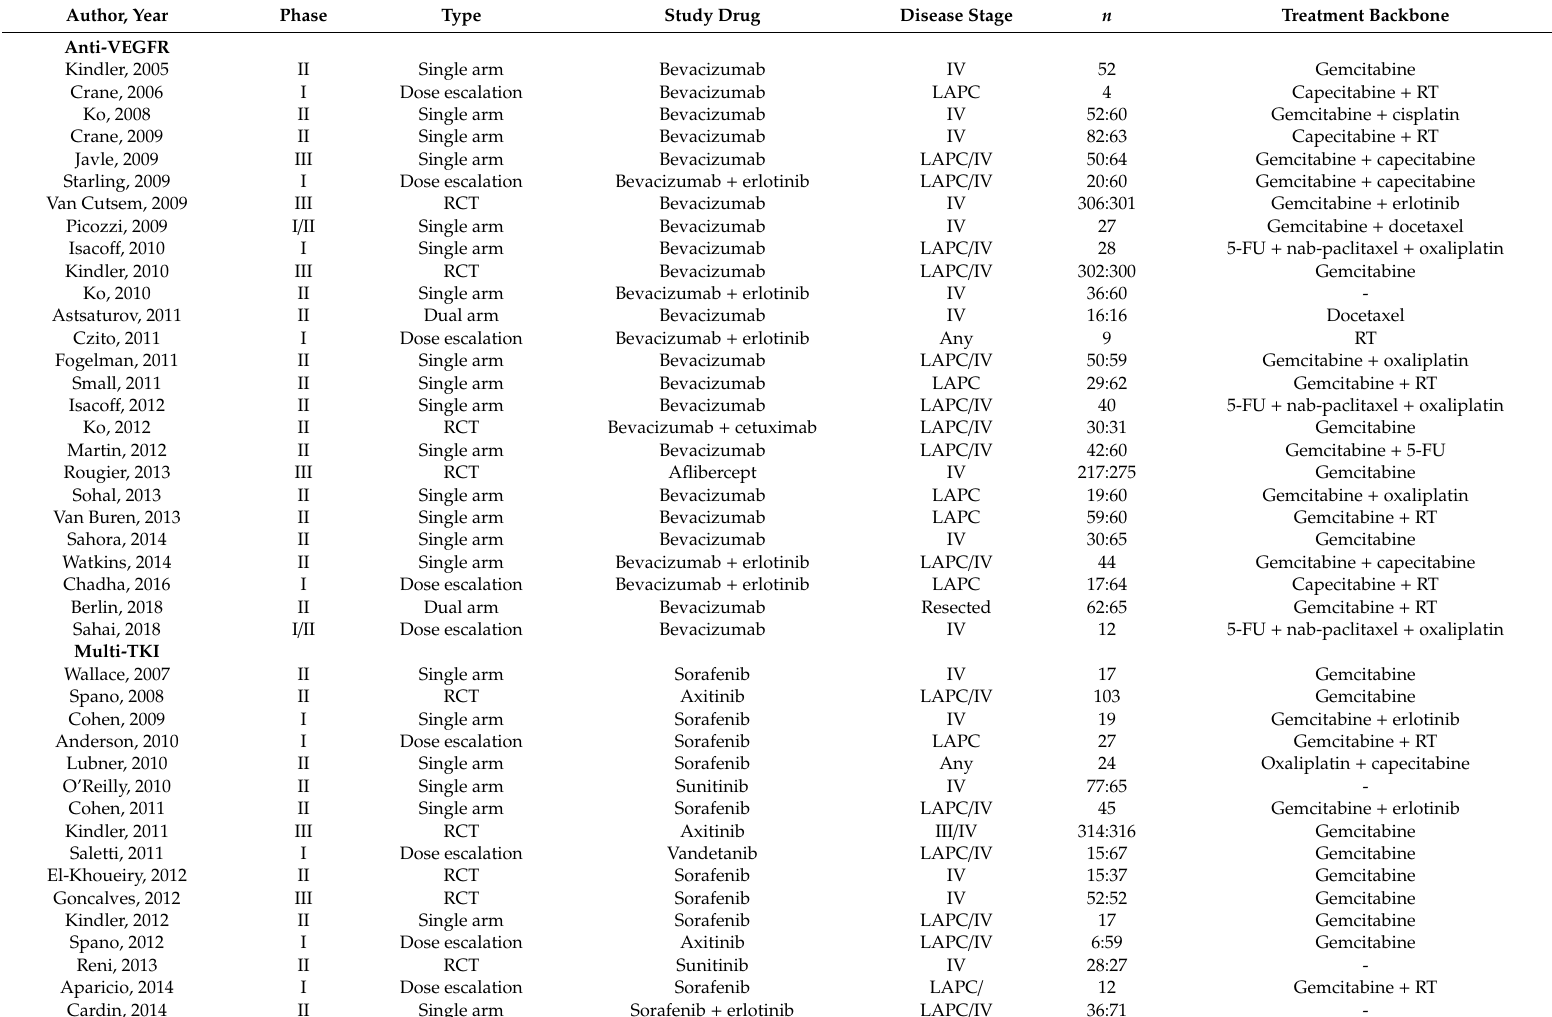
Table 1. All clinical trials included in this